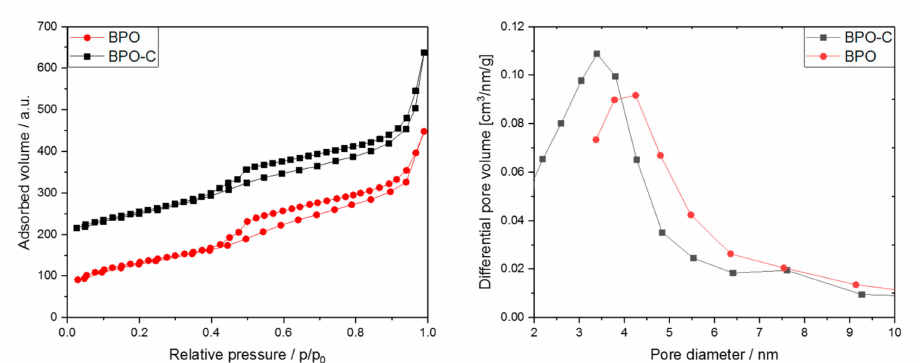
Figure 4. Sorption measurements for samples BPO and BPO-C. Sorption curves are shown in the left graph. The curves were separated by 100 cm 3 g − 1 for clarity. BJH pore size distributions are illustrated in the right